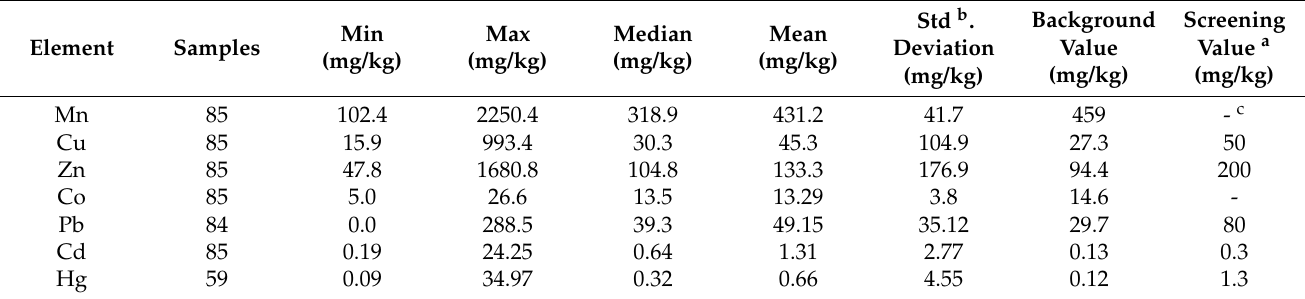
Table 1. Total concentrations of PTEs in the soil samples.